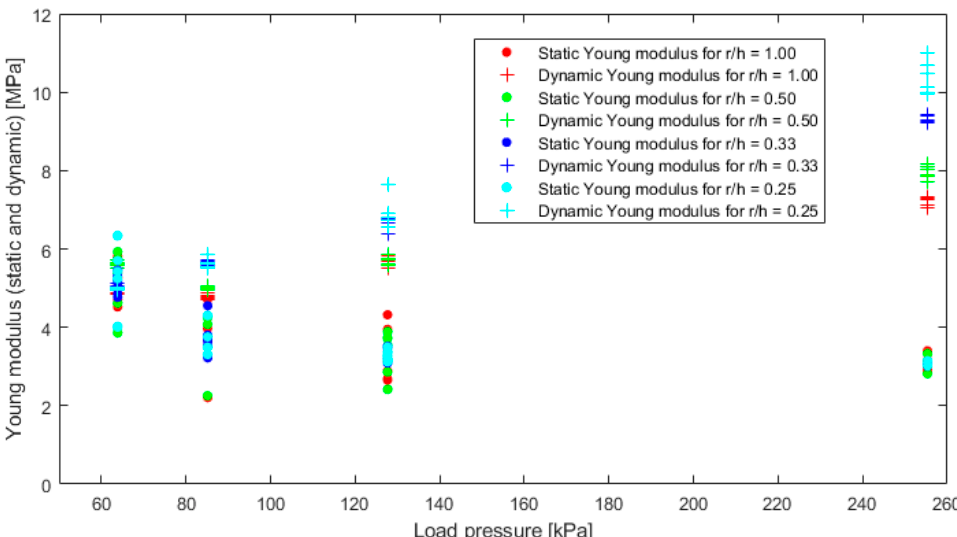
Figure 18. Comparison of static and dynamic Young’s modulus with assumption E a /E = 1.03 for r/h = 0.25.